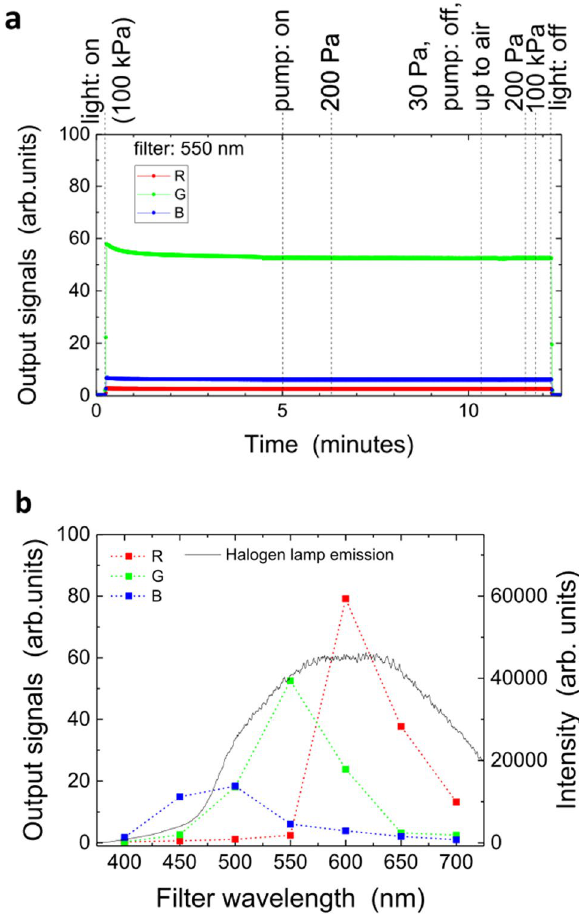
Figure 2. Output signals of the sensor when light originates from the halogen lamp located outside the chamber and enters the sensor inlet through the glass vessel. (a) Time evolution of the signals detected by the optical sensor located in the pressure-varying chamber. A bandpass filter with a centre wavelength of 550 nm is inserted on the outlet of the optical fibre that guides light from the lamp. (b) Signals of the R, G, and B components as a function of the centre wavelength bandpass filter. The halogen lamp emission spectrum detected by the monochromator is also shown. The values shown here are approximately 200 Pa, although they are invariant, as shown in (a) , regardless of